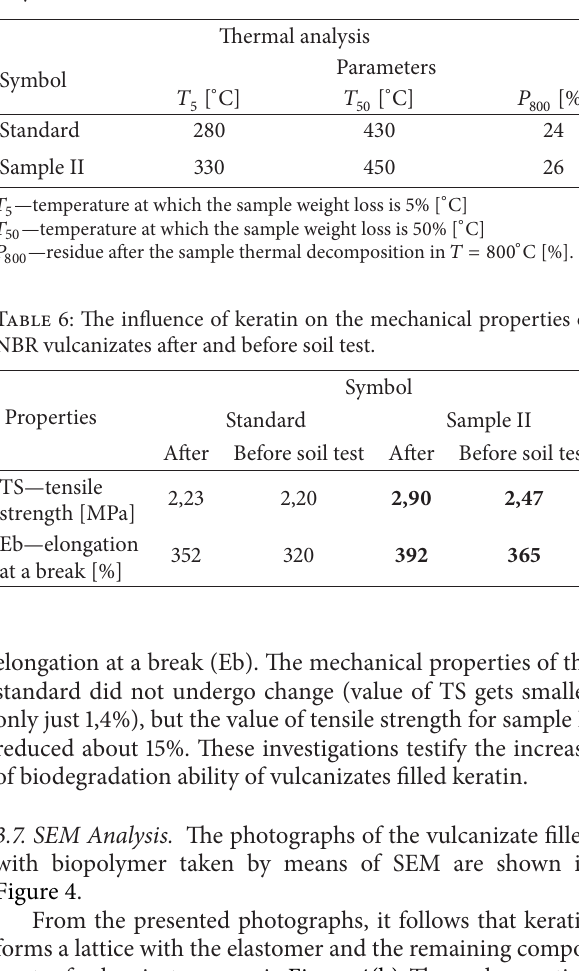
Table 5: Thermal analyses of filled and unfilled vulcanizates of acrylonitrile-butadiene rubber NBR.